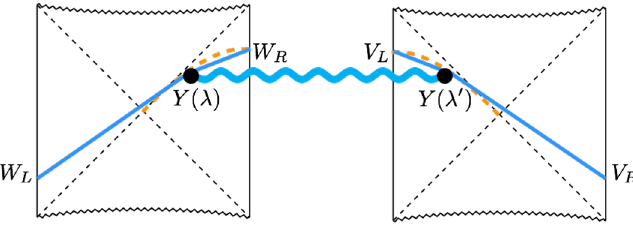
Figure 3 . Half-geodesic Witten diagram in the two-sided Rindler-AdS black hole. The left Penrose diagram is the black hole at x = x scalar bulk-to-boundary propagators between boundary points ( W ( Y ( λ ) , Y ( λ 0 )) . A wavy line is a bulk-to-bulk propagator between the bulk points. The bulk points Y ( λ ) and Y ( λ 0 ) are integrated over half-geodesics ( γ R